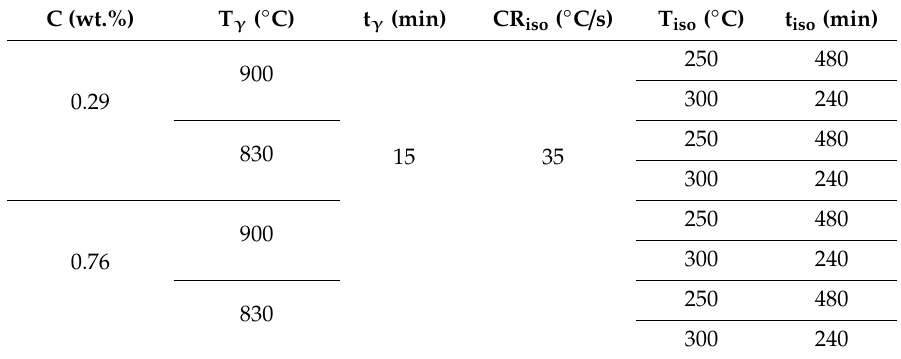
Table 4. Heat treatment conditions for isothermal test. Where T γ and T iso stands for the austenitization and austempering temperature, respectively, whereas t γ and t iso stand for the respective times. CR iso is the cooling rate from the austenitizing temperature to the temperature of the isothermal treatment.